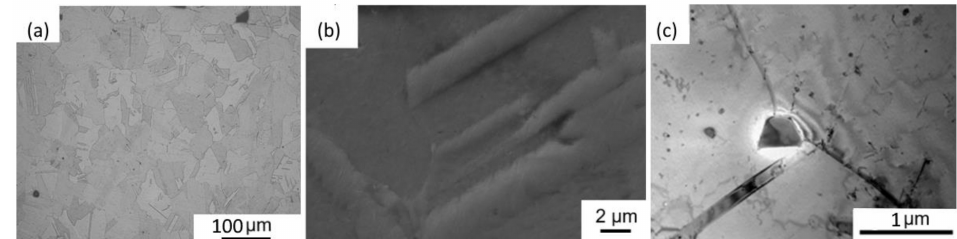
Figure 11. ( a ) OM image; ( b ) SEM image, and ( c ) TEM image of solution annealed micro-LPBF Inc718.